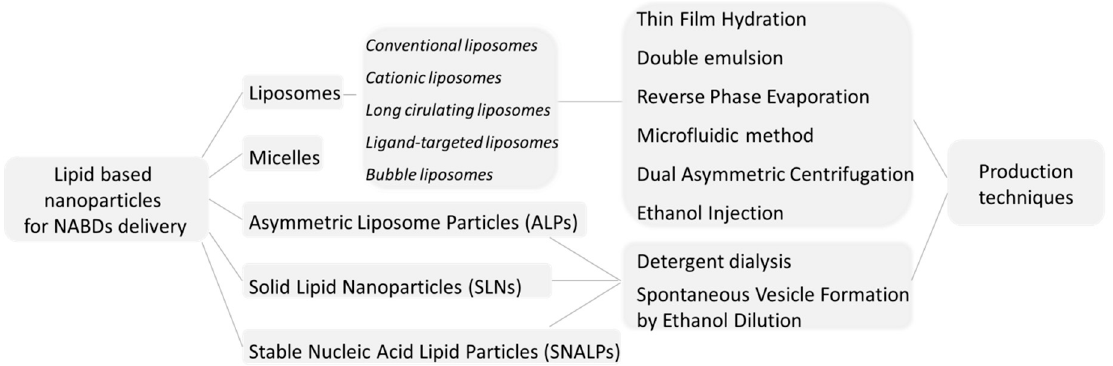
Figure 1. Schematization of lipid-based nanoparticles that are used for Nucleic Acid Based Drugs (NABDs) delivery and their production techniques.